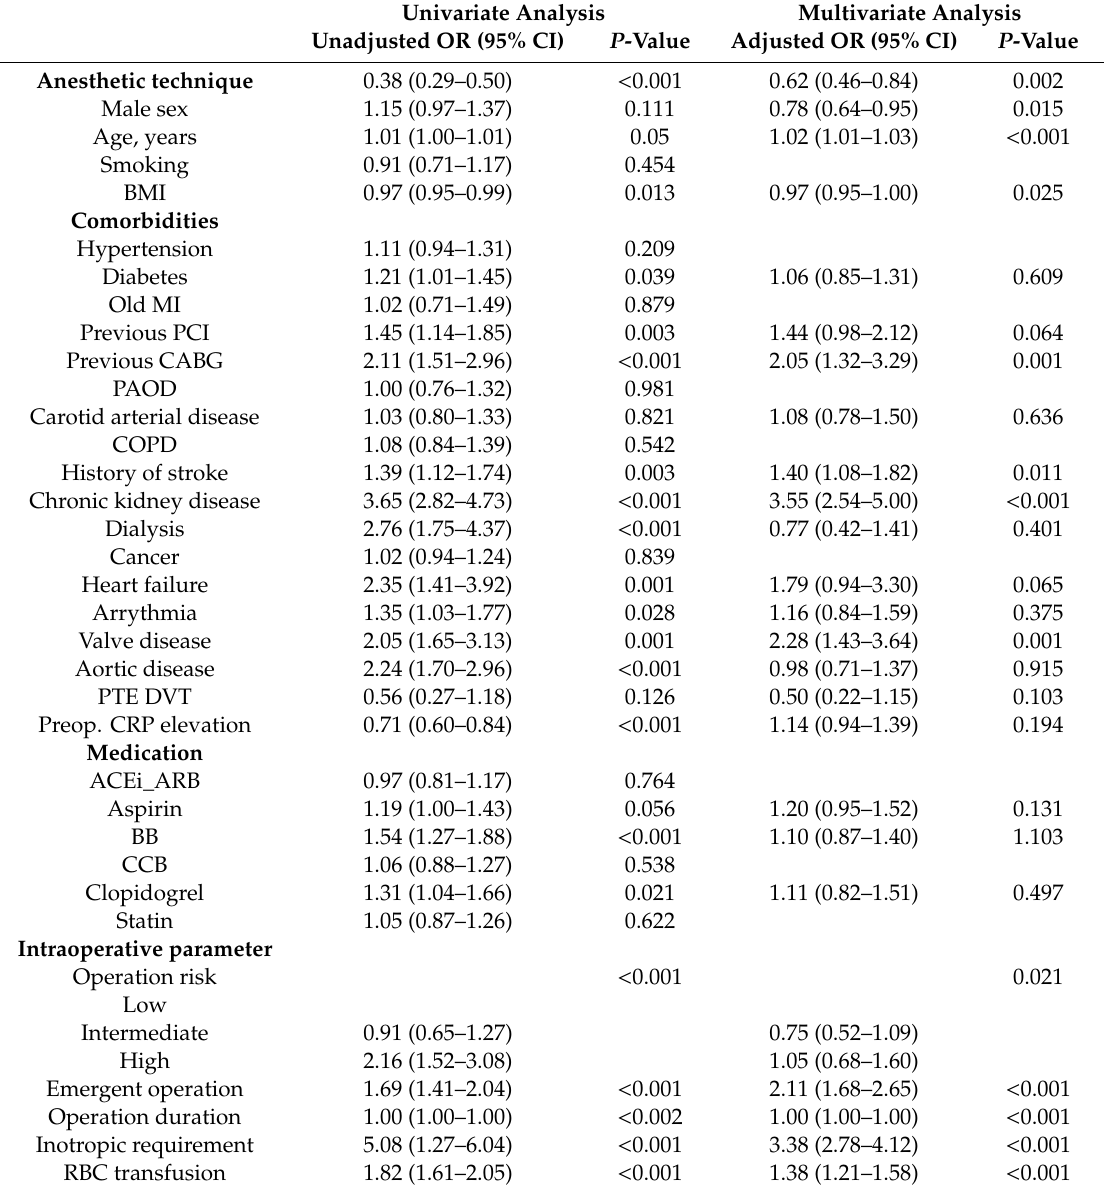
Table 5. Variables associated with myocardial injury after non-cardiac surgery